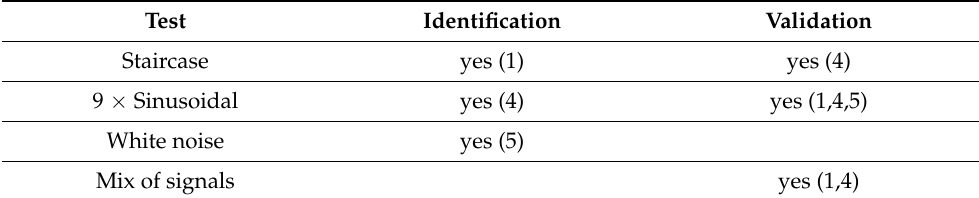
Table 3. Experimental test matrix.